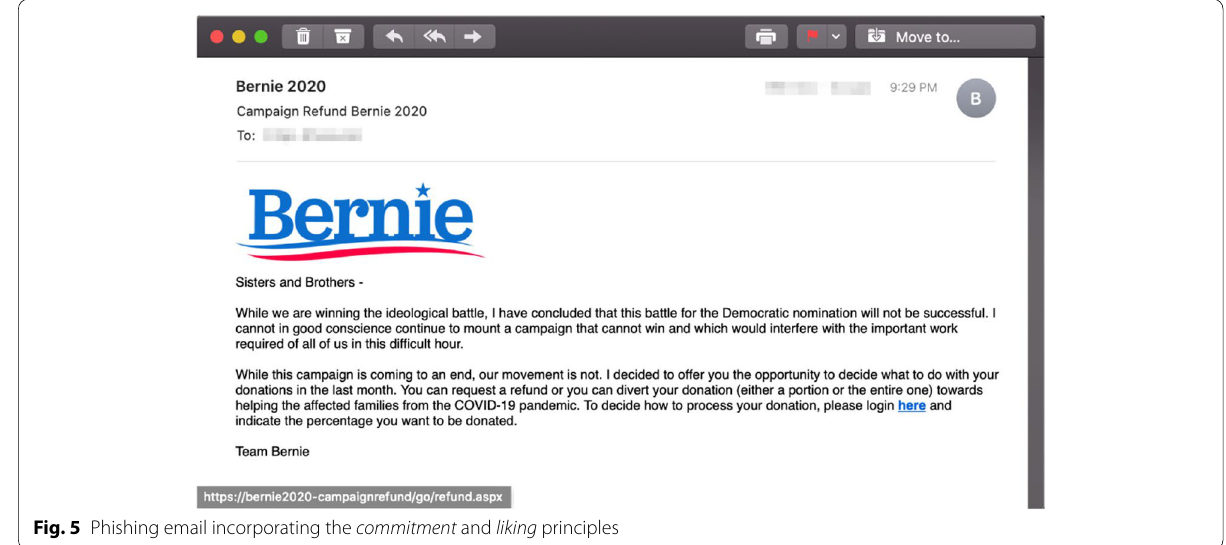
Fig. 5 Phishing email incorporating the commitment and liking principles